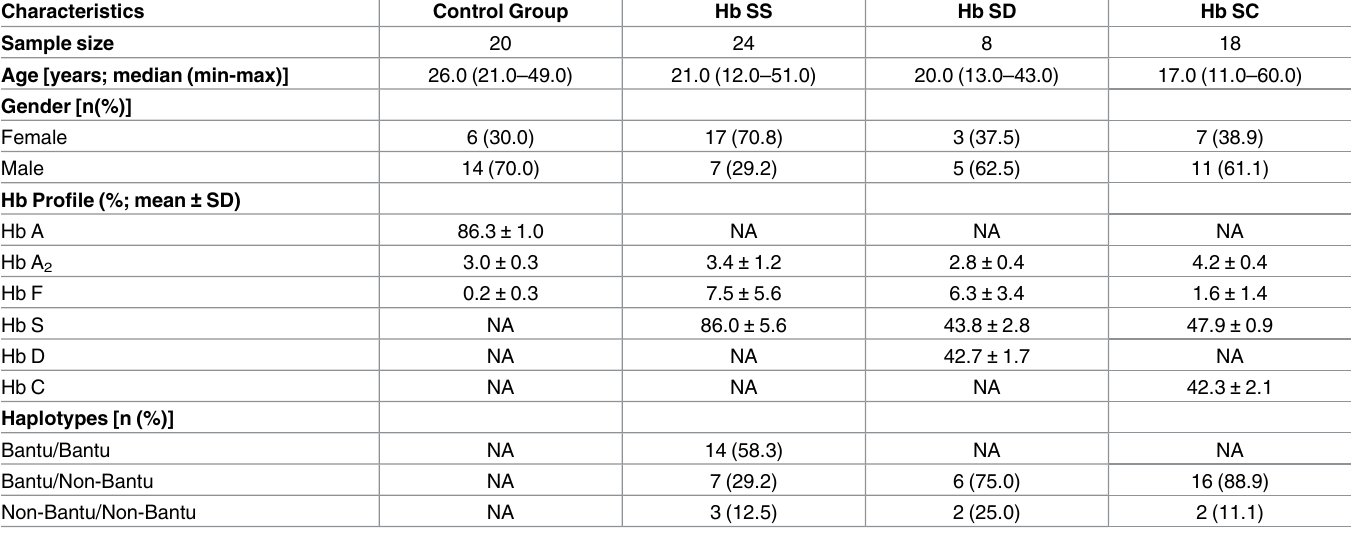
Table 1. Characterization of the study groups.